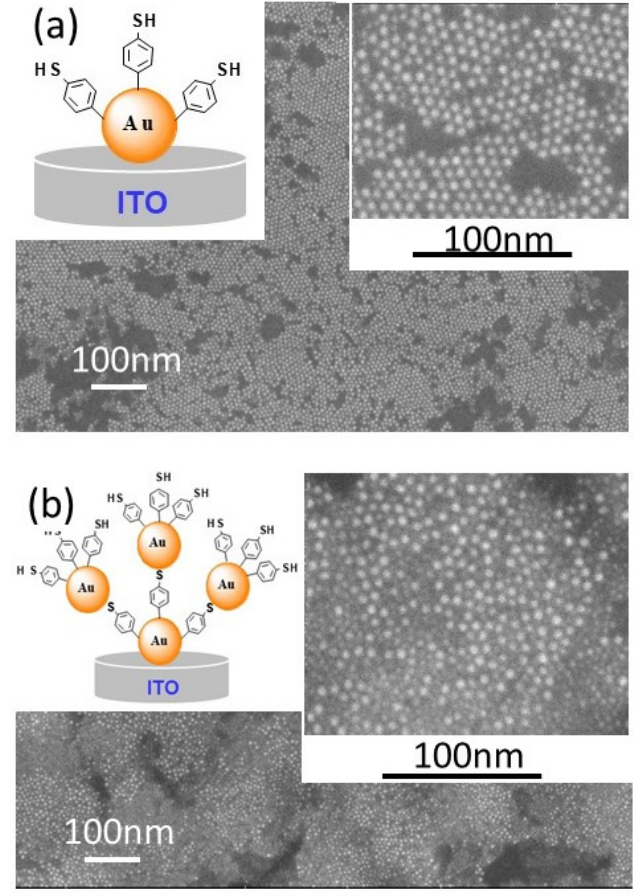
Figure 4. FEG-SEM images of modified ITO electrodes with self-assembled AuNPs and 4-thiolphenyl as indicated in the inserted cartoons of ( a , b ). The inserted images of ( a , b ) show the corresponding high magnifications of FEG-SEM images.